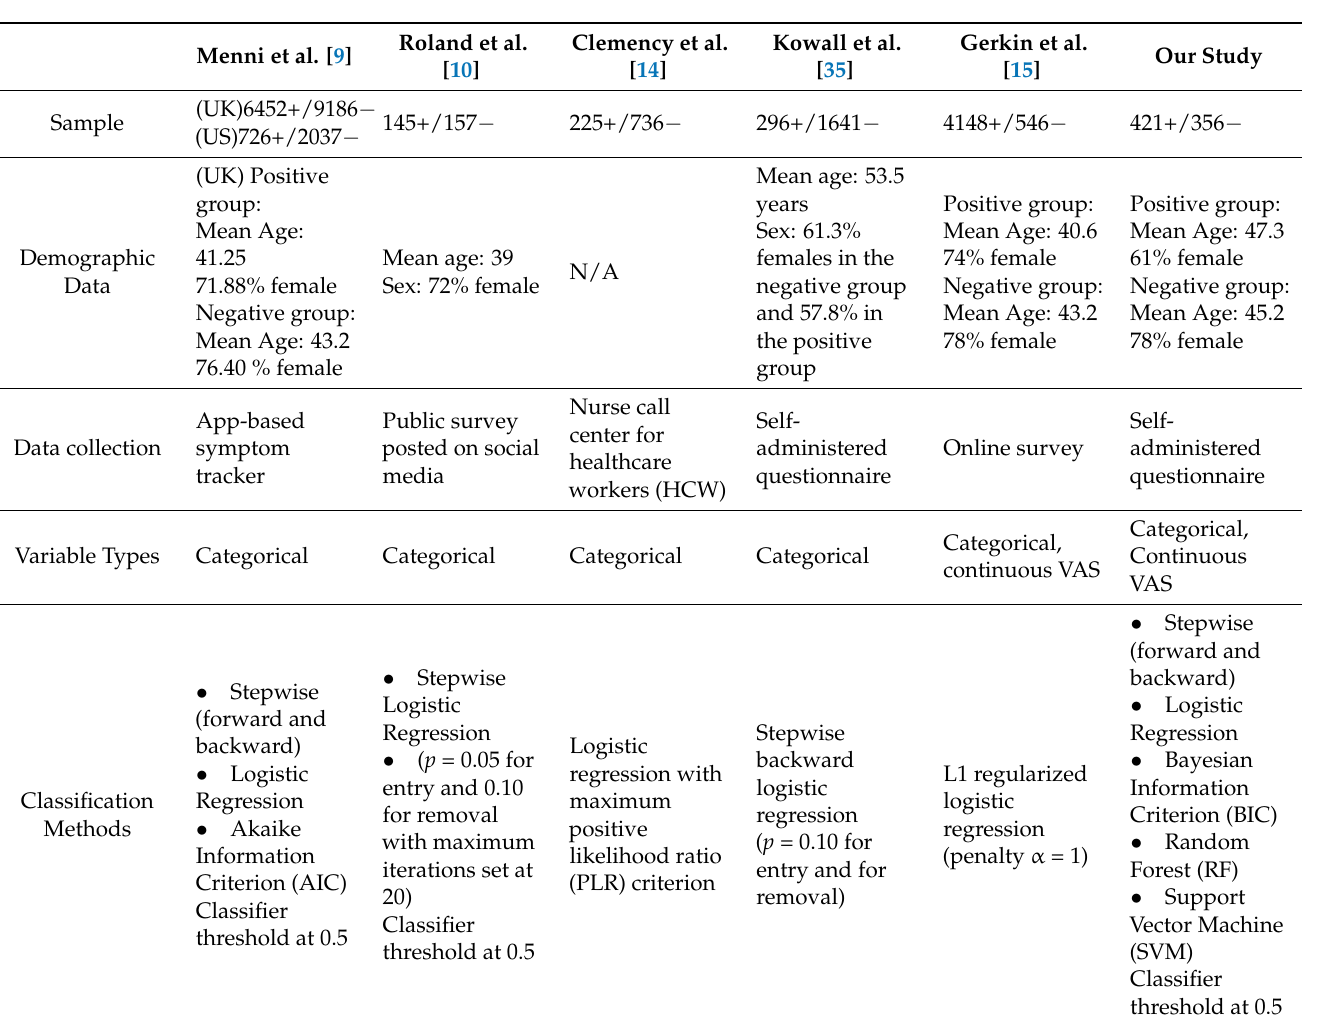
Table 5. Table summarizing the main characteristics of COVID-19 prediction models reported in the literature based on loss of smell and